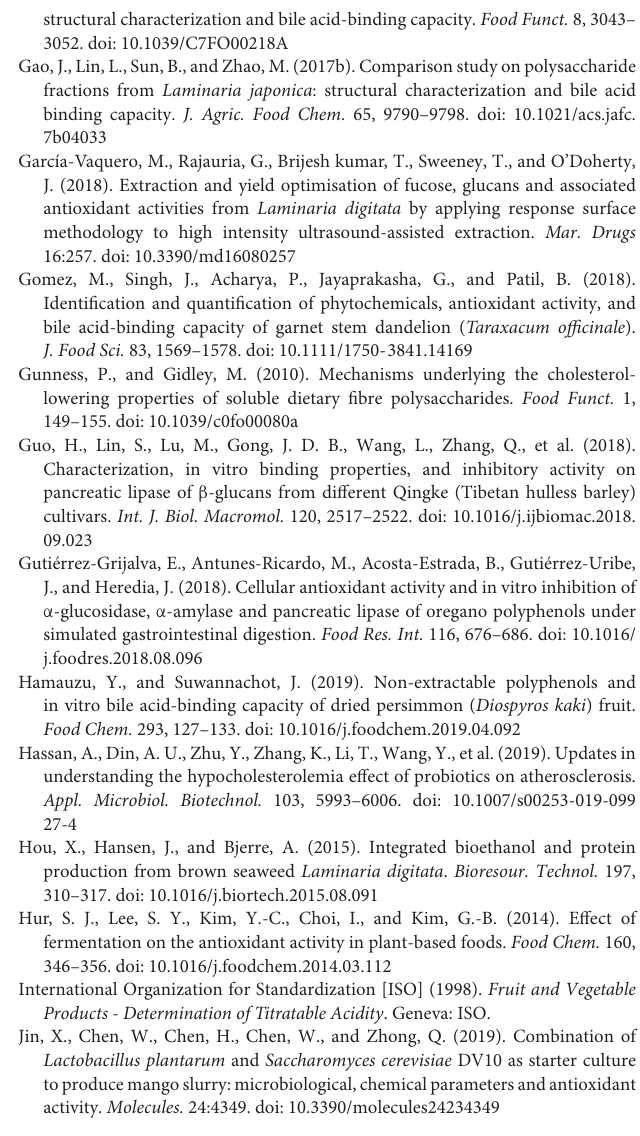
Supplementary Figure 1 | Cell growth of L. plantarum (A) and S. cerevisiae (B) during single culture